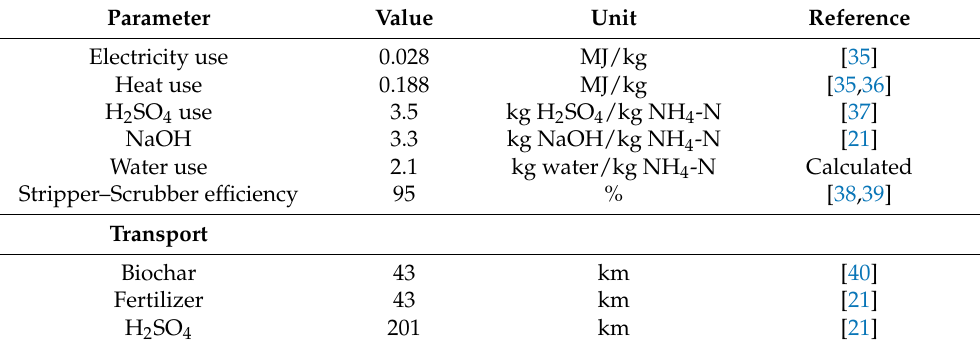
Table 5. Stripping and scrubbing parameters.